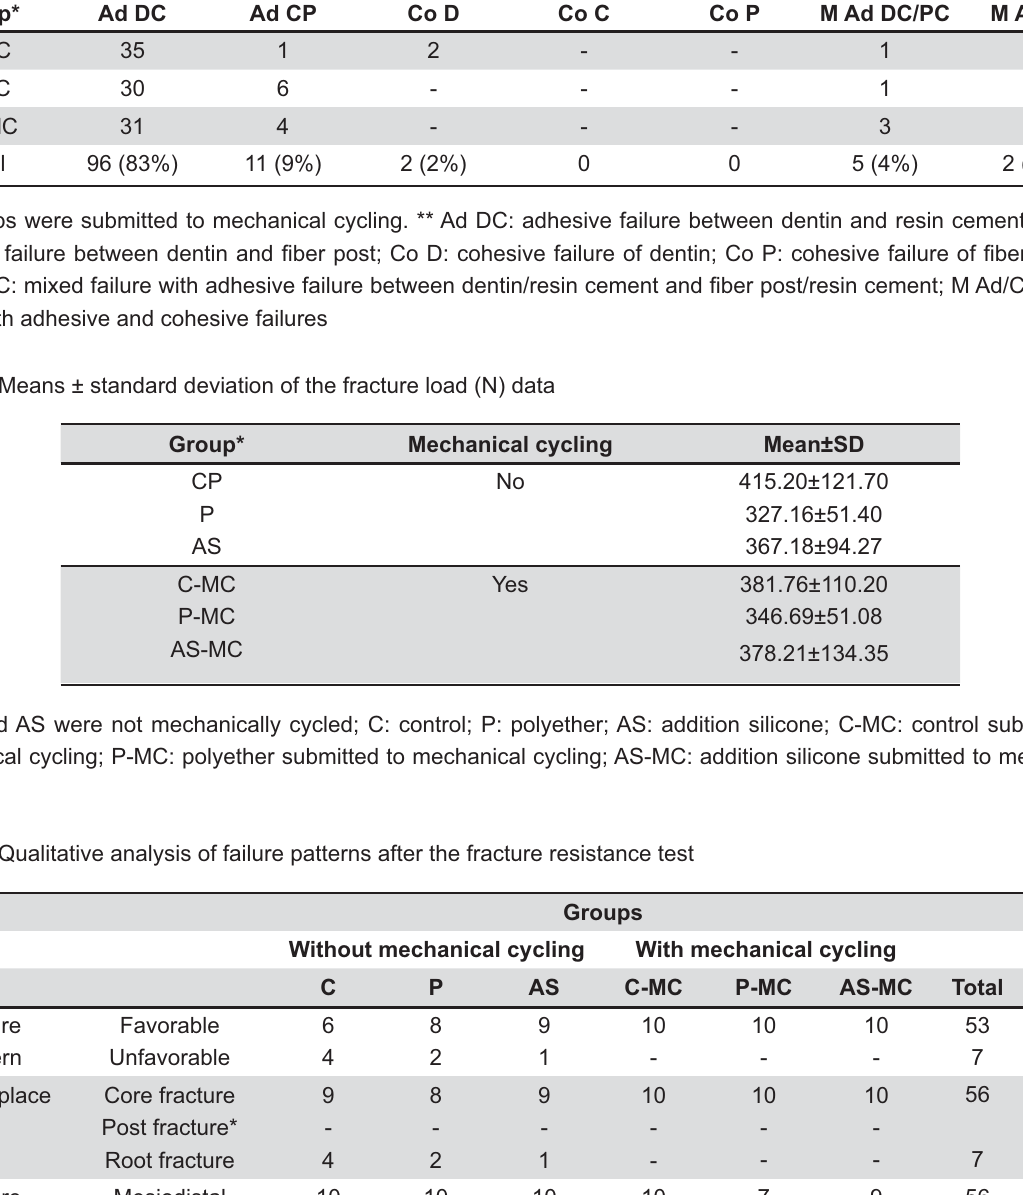
Table 3. Two-way ANOVA showed that the simulation of the periodontal ligament (p=0.153), the mechanical cycling (p=0.97), and the interaction between the two